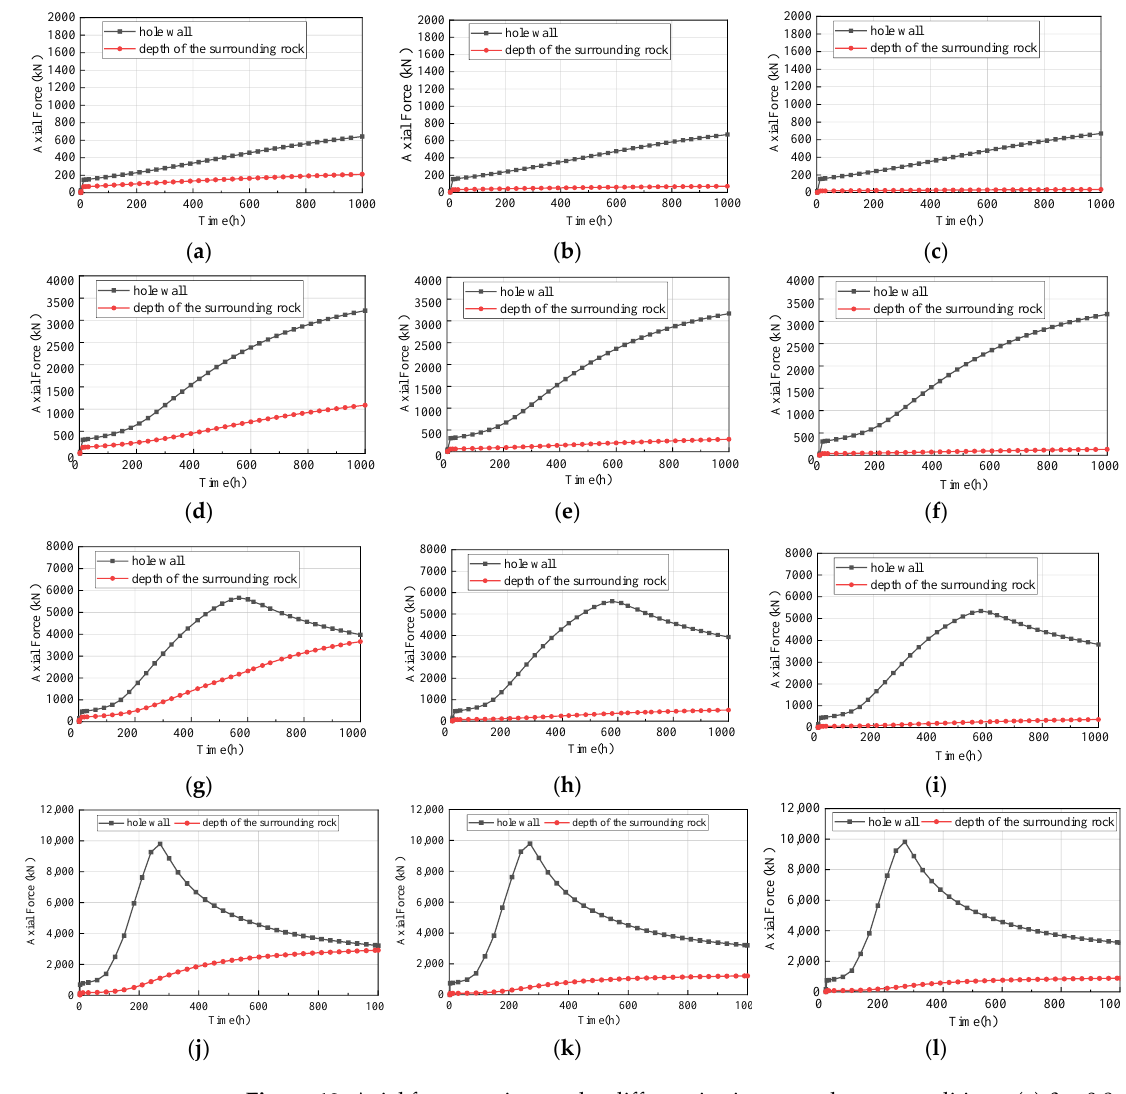
Figure 10. Axial force vs. time under different in situ ground stress conditions: ( a ) β = 0.8 and ξ = 0.3; ( b ) β = 0.8 and ξ = 0.7; ( c ) β = 0.8 and ξ = 0.9; ( d ) β = 0.4 and ξ = 0.3; ( e ) β = 0.4 and ξ = 0.7; ( f ) β = 0.4 and ξ = 0.9; ( g ) β = 0.26 and ξ = 0.3; ( h ) β = 0.26 and ξ = 0.7; ( i ) β = 0.26 and ξ = 0.9; ( j ) β = 0.16 and ξ = 0.3; ( k ) β = 0.16 and ξ = 0.7; ( l ) β = 0.16 and ξ =